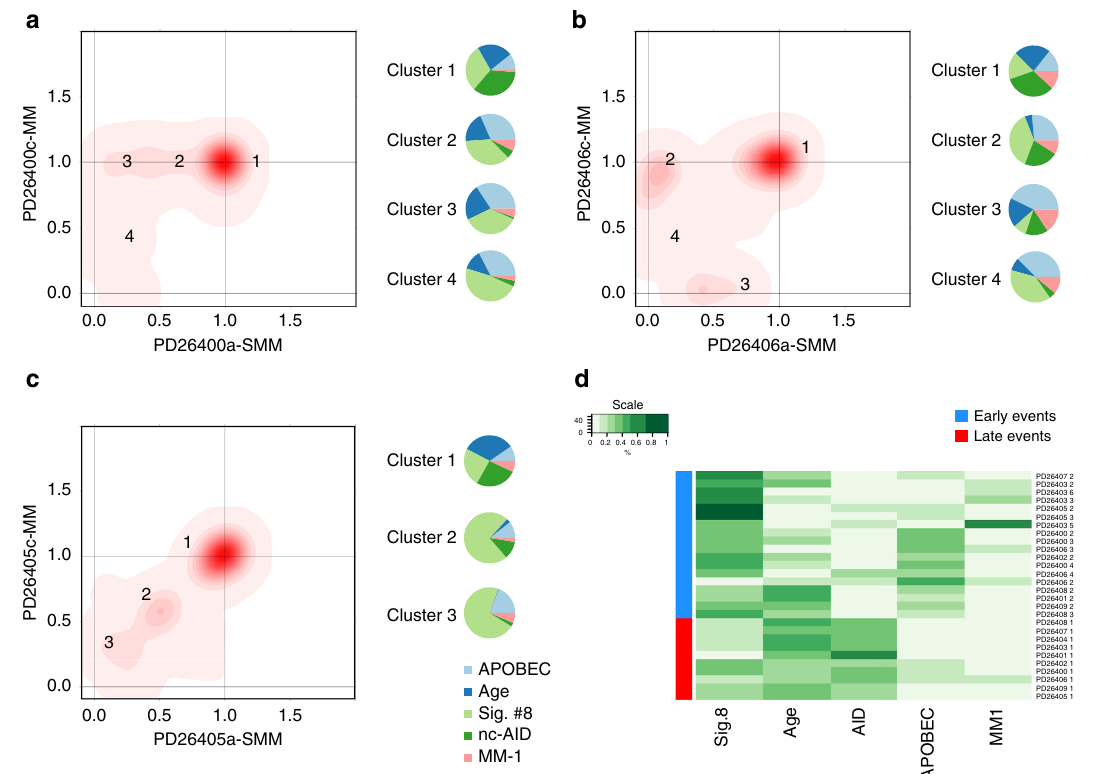
Fig. 6 Mutational signature contribution during SMM progression. a – c Three examples of different mutational signatures contribution during SMM progression. The nc-AID contribution was particularly enriched in cluster 1 (clonal events) of all patients. Conversely, its contribution was signi fi cantly decreased or virtually absent among all later events. This different chronological mutational signature activity was observed in all investigated cases, where all early clonal events were clustered together in a cluster enriched for nc-AID activity ( d